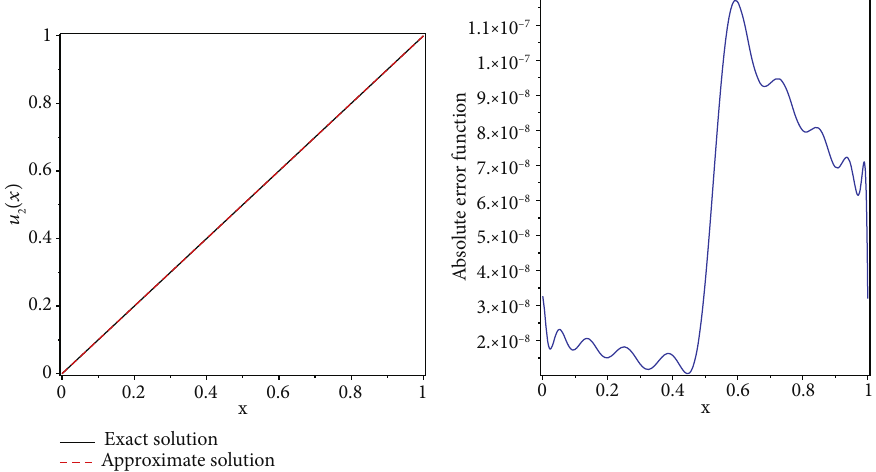
Figure 2: The graphs of the exact and approximate solutions and the absolute error function of ~ u